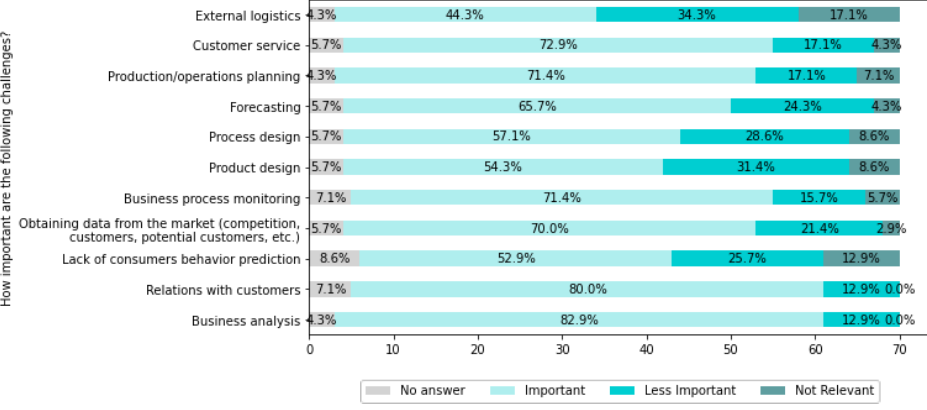
Figure 16. Challenges related to customer acquisition and contract planning — number of question- naires in a total number of 70 questionnaires.